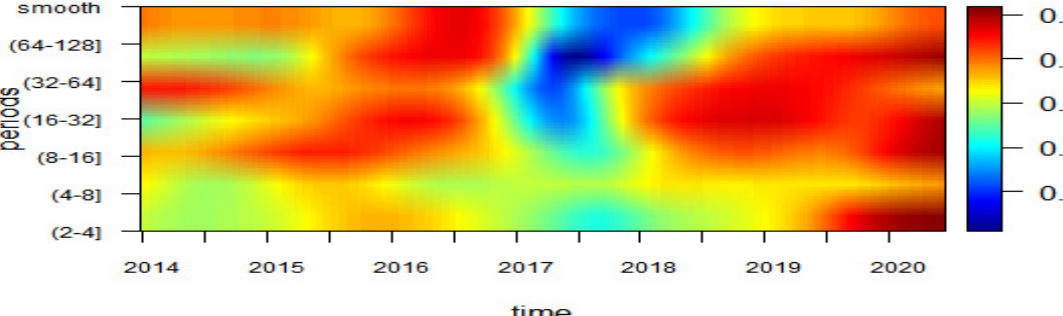
Figure 5. Wavelet multiple correlations between the S&P 500 and S&P/TSX stock market returns. Note: the heat map indicates the increasing strength of the correlation among the stock markets’ indices as they move from blue (lowest correlation) to red (highest correlation).